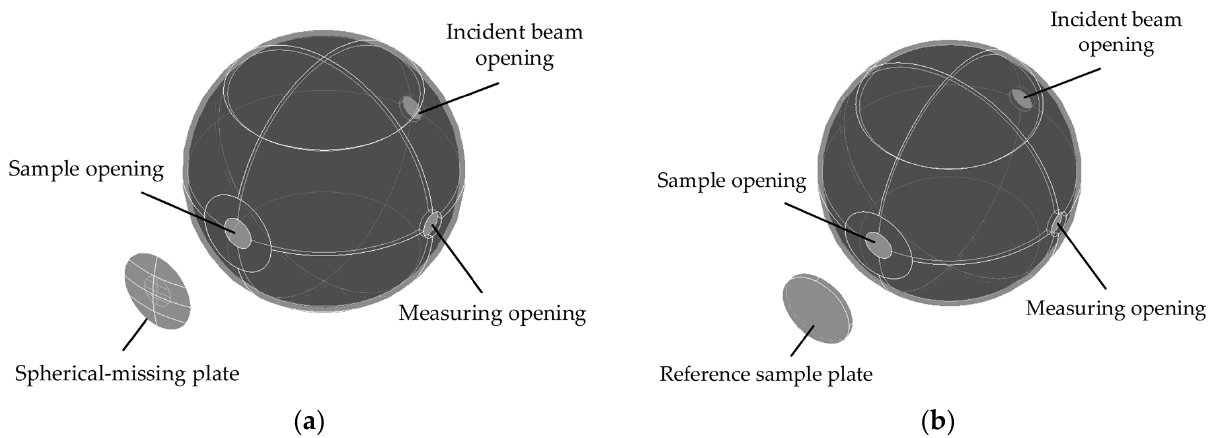
Figure 5. Geometric model of three-hole integrating sphere: ( a ) with spherical-missing plate and ( b ) with sample plate.